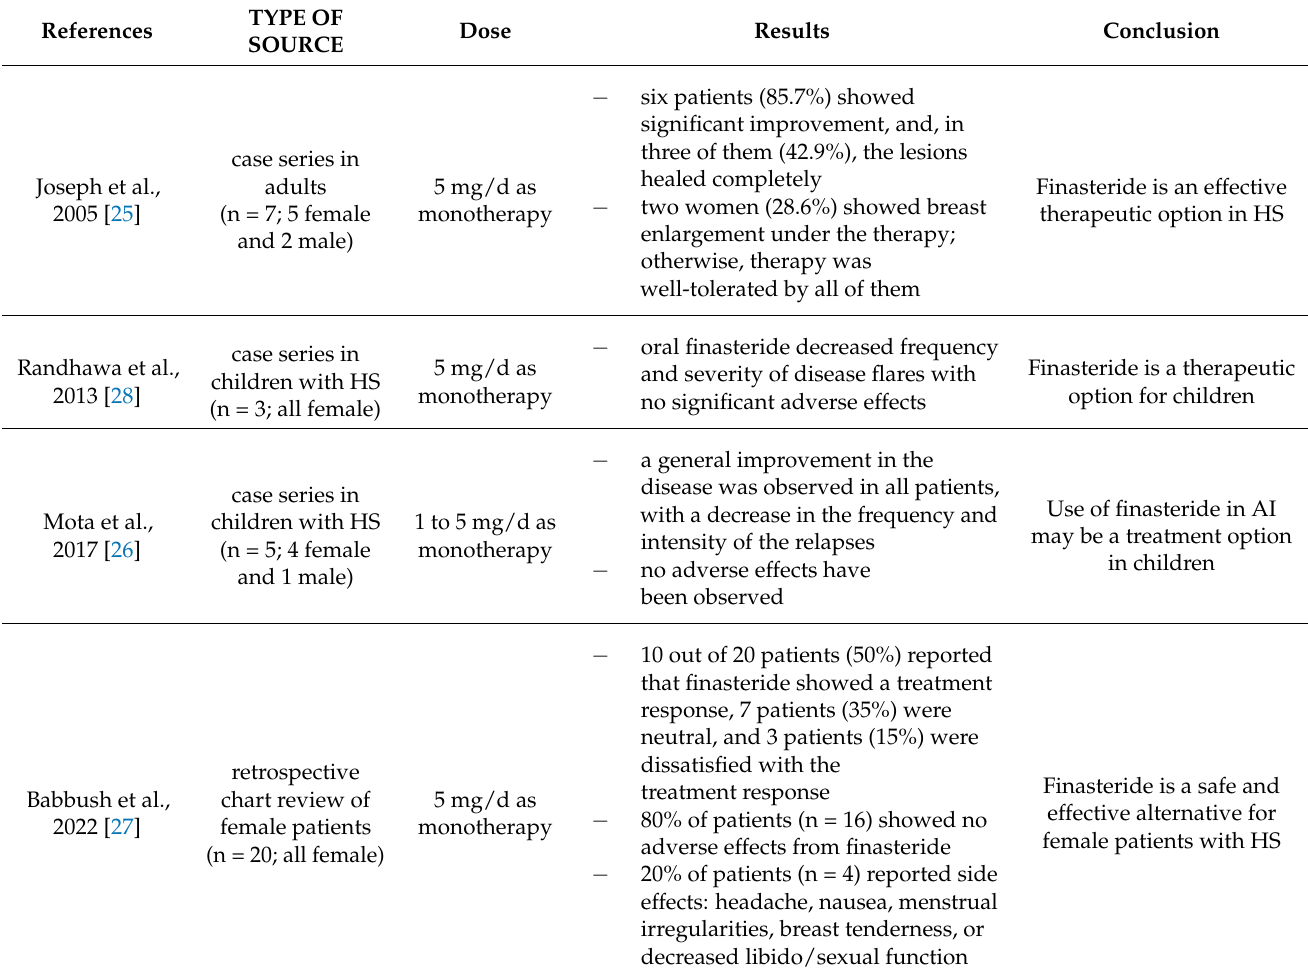
Table 3. The use of finasteride (antiandrogen therapy, inhibitor of steroid 5 α -reductase) in